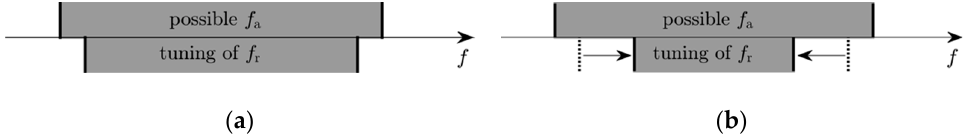
Figure 5. Two adjustment-range strategies. ( a ) State A. ( b ) State B, with a narrowed adjustment bandwidth relative to state A ( s <1).